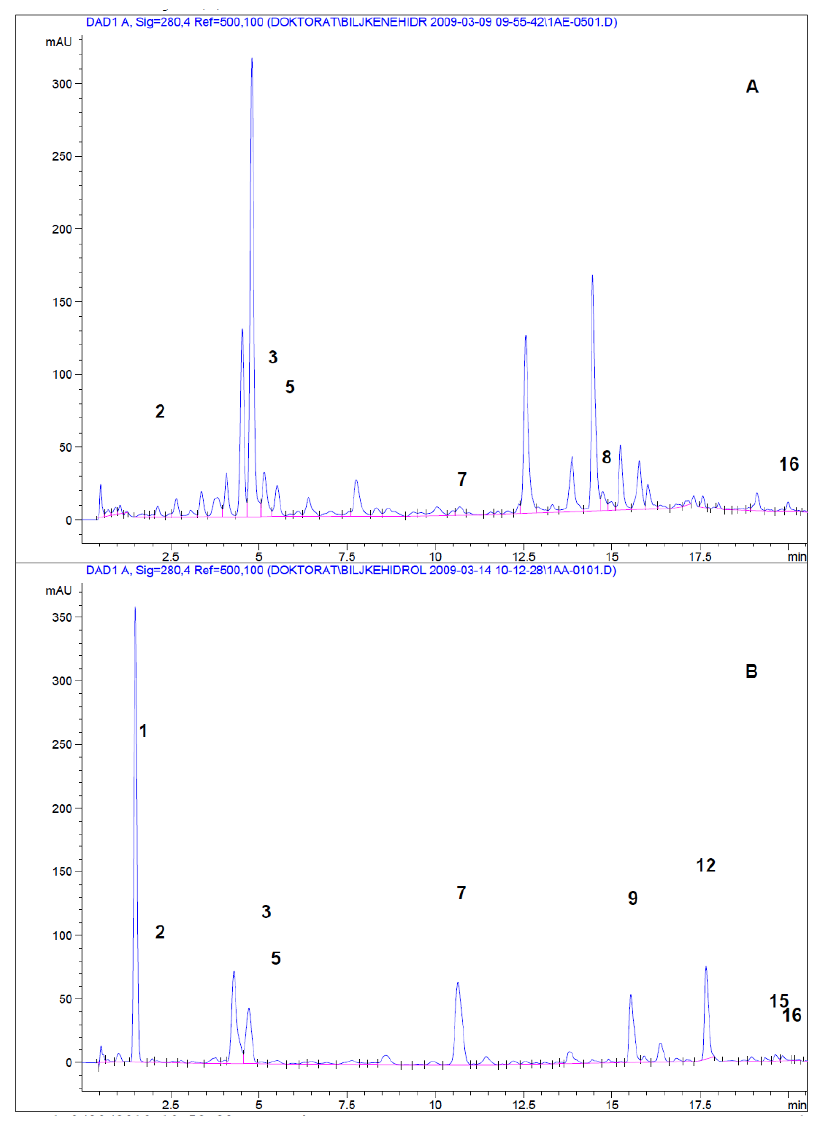
Figure 2. Chromatogram of the crude birch extract at 280 nm, A-prior, B-after hydrolysis: 1-gallic acid, 2-protocatechuic acid, 3-caffeic acid, 5-chlorogenic acid, 7-ferulic acid, 8-rutin, 9-myricetin, 12-quercetin, 15-kaempferol and